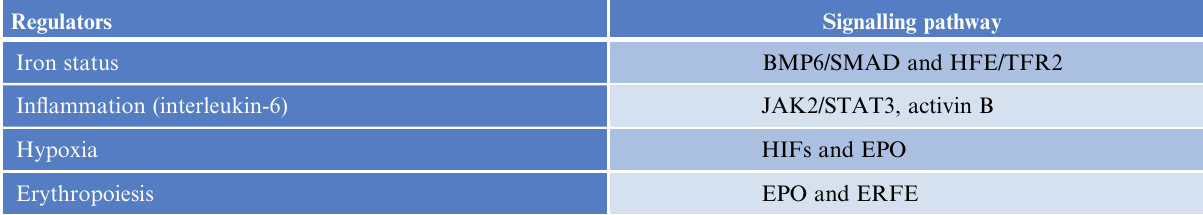
Table 1. Regulation of hepcidin Regulators Signalling pathway Iron status BMP6/SMAD and HFE/TFR2 In fl ammation (interleukin-6) JAK2/STAT3, activin B Hypoxia HIFs and EPO Erythropoiesis EPO and ERFE BMP6: bone morphogenic protein 6; SMAD: mothers against decapentaplegic-related protein; HFE/TFR2: haemochromatosis iron protein/ transferrin receptor 2; JAK: Janus kinase; STAT3: signal transducer and activation of transcription 3; HIFs: hypoxia-inducible factors; EPO: erythropoietin; ERFE: